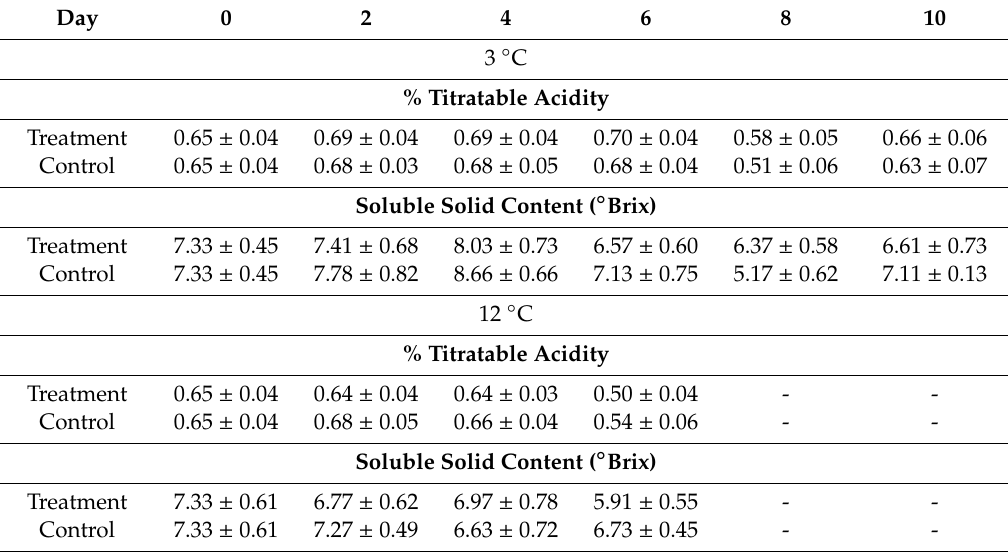
Table 1. Titratable acidity and soluble solid content of strawberries stored at 3 ◦ C for 10 days or 12 ◦ C for 6 days in molded fiber baskets containing pullulan packaging films loaded with 1% w / w cinnamaldehyde SLN (treatment) or without